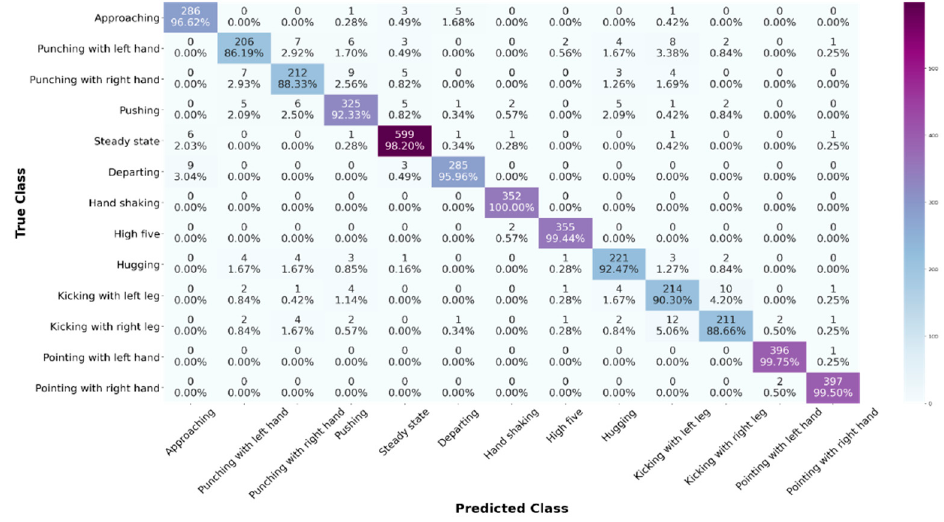
Figure 4. The confusion matrix of the HHI-AttentionNet model for HHIs recognition.